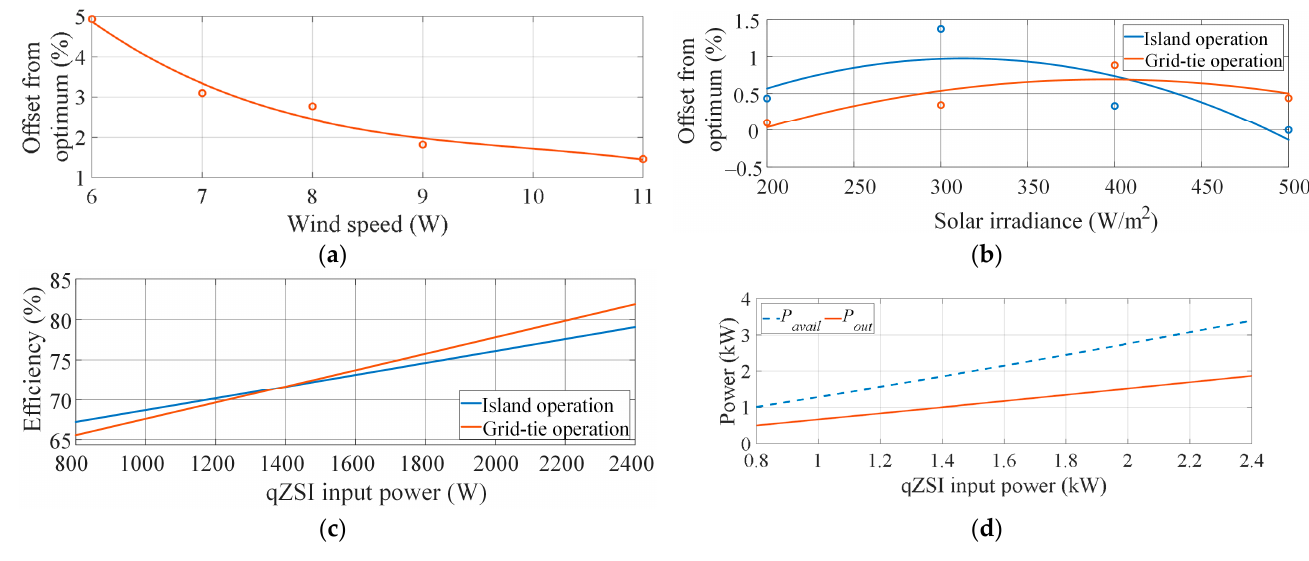
Figure 21. Steady-state characteristics depicting ( a ) WT MPPT accuracy vs. wind speed; ( b ) PV MPPT accuracy vs. solar irradiance; ( c ) qZSI efficiency vs. qZSI input power; ( d ) output power and available output power vs. qZSI input power. Table 2. Comparison of MPPT accuracy.